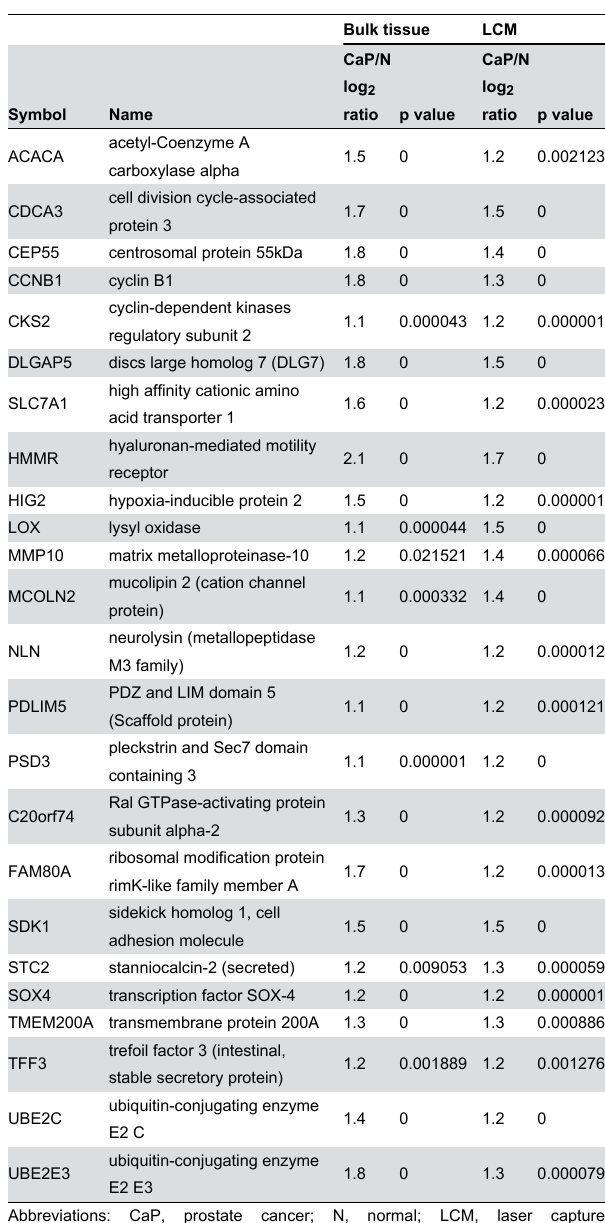
Table 2. Hypoxia-associated genes significantly overexpressed in CaP bulk tissue and samples isolated by LCM.